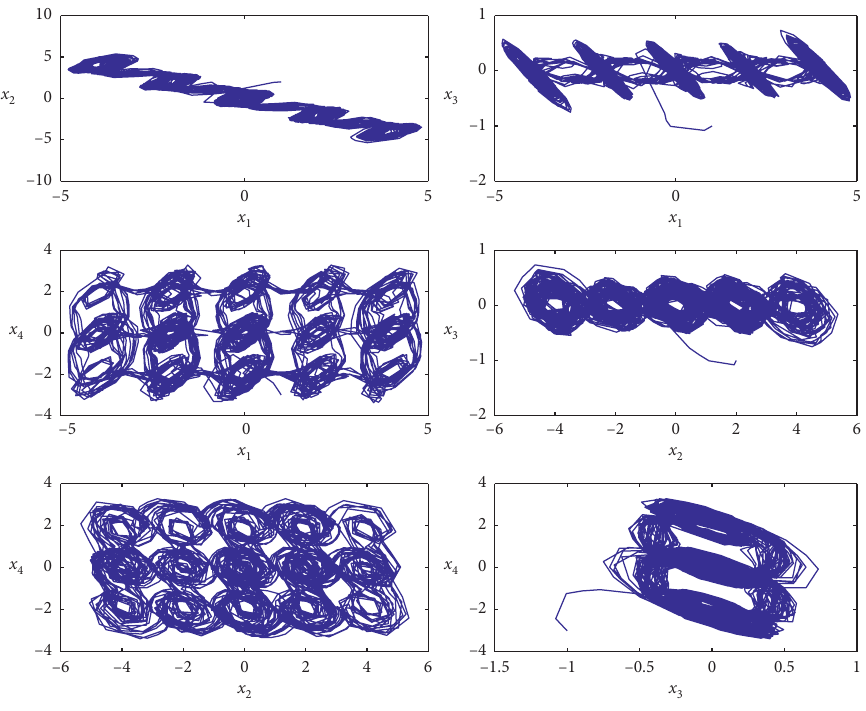
Figure 1: Multiscroll chaotic attractor of system (1) with M � 2and N � 1.